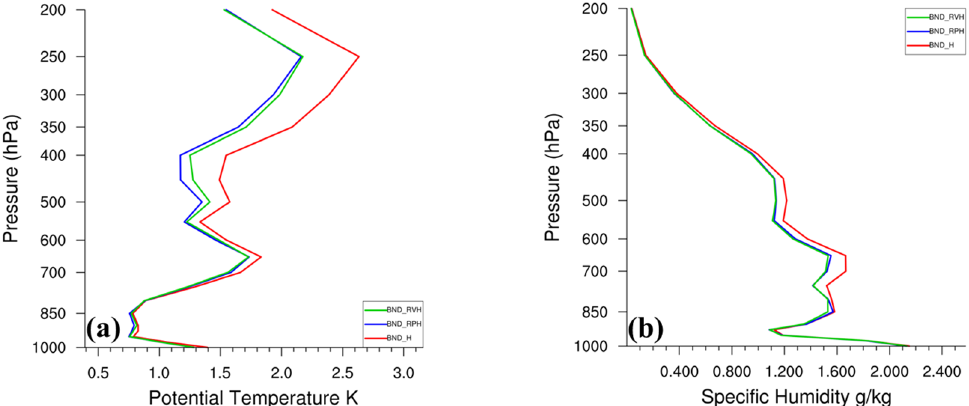
Figure 15. The RMS forecast errors for BND_RVH (green), BND_RPH (blue), and BND_H (red) verified against the ERA-Interim for ( a ) potential temperature (in K) and ( b ) specific humidity (g kg − 1 ), at 0000 UTC 7 July 2016.